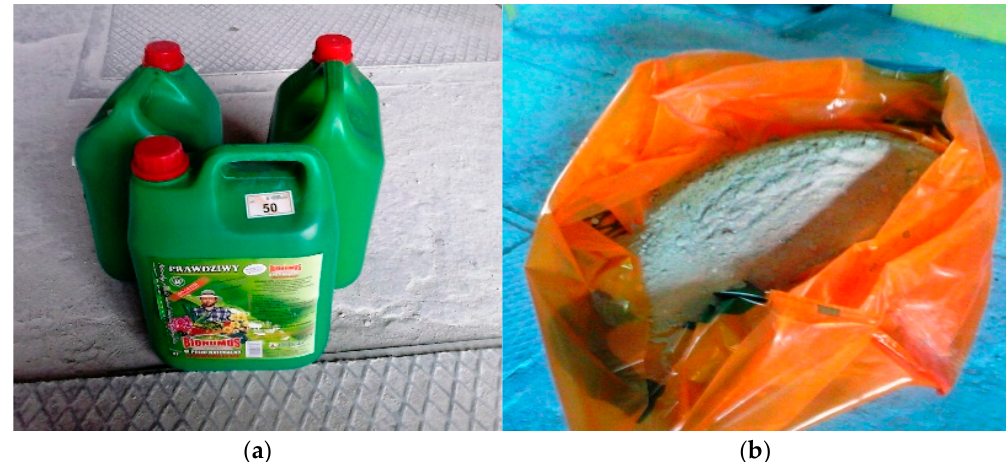
Figure 6. Substrates for the production of lime–sand brick modified with biohumus (biohumus in liquid form and quartz sand): ( a ) mix modifier used in the lime–sand mixture; and ( b ) modified sand–lime mixture.